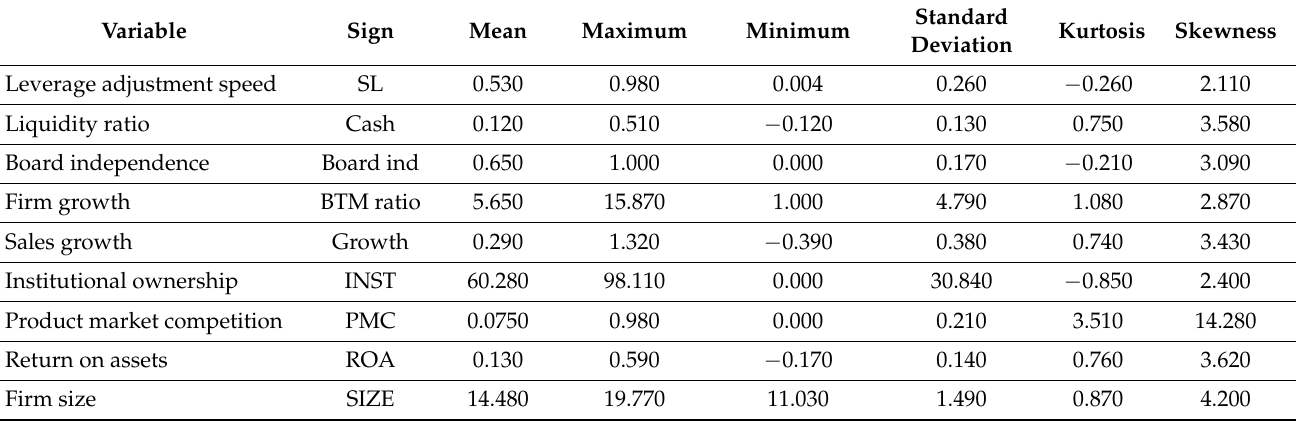
Table 2. The Descriptive statistics of quantitative research variables.